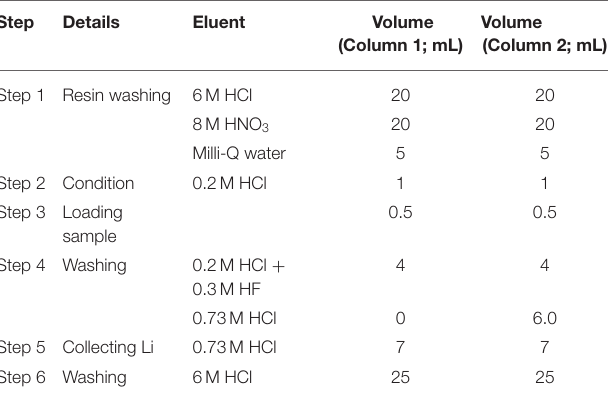
TABLE 2 | Two-column Li separation procedures for carbonate samples using AGMP-50 resin.